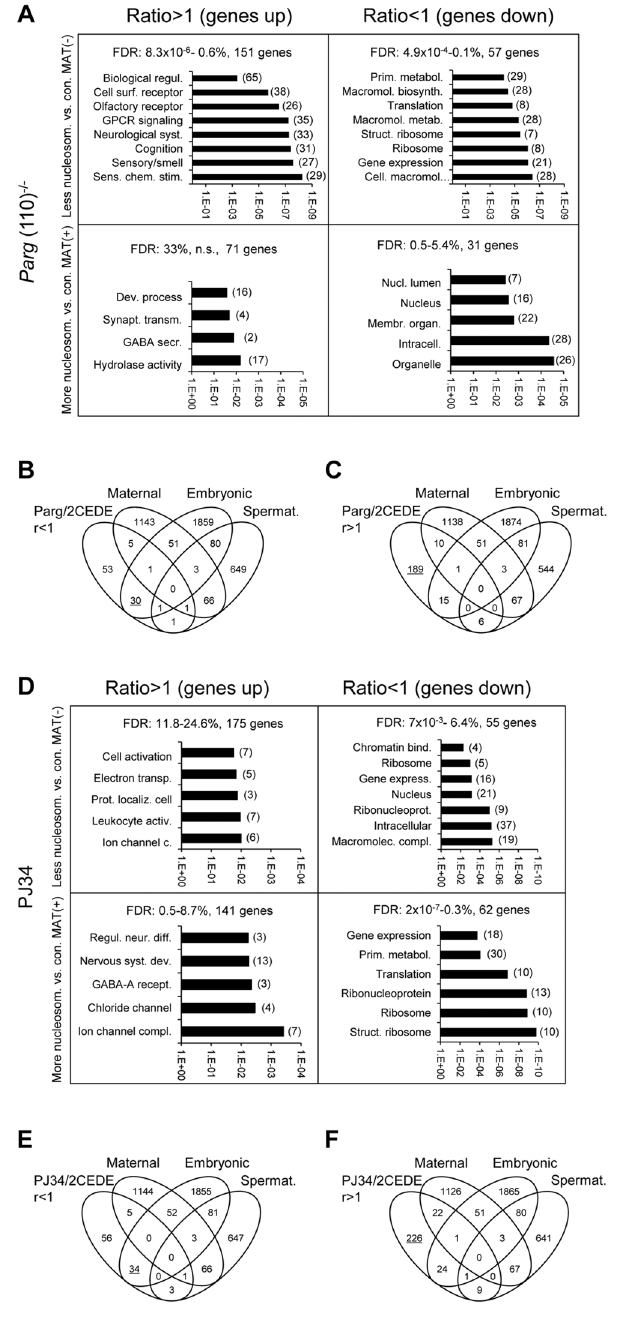
Figure 5. Genes that are affected by altered sperm histone association and differential gene expression in 2-cell embryo progeny in the Parg (110) 2 / 2 (A, B, C) and PJ34-treated (D, E, F) mouse models share some common functional relevance. Analyses of functional ontology of genes that are both affected by elevated (MAT( + )) or lower (MAT( 2 )) differential histone association in sperm and differential expression in resulting embryos (2CEDE/MND) were performed in the Parg (110) 2 / 2 (A) or PJ34 (D) model system. Genes are listed according to up- (ratio . 1) or down (ratio , 1) regulation compared to controls in offspring from Parg (110) 2 / 2 or PJ34 treated males and p-values of the GO terms (DAVID) associated with the corresponding group of genes are given on the logarithmic x- axis. The number of genes in each GO functional category is in parentheses. FDR: false discovery rates. (B, C, E, F) Comparing lists of genes that were either down-regulated (B, E) or up-regulated (C, F)